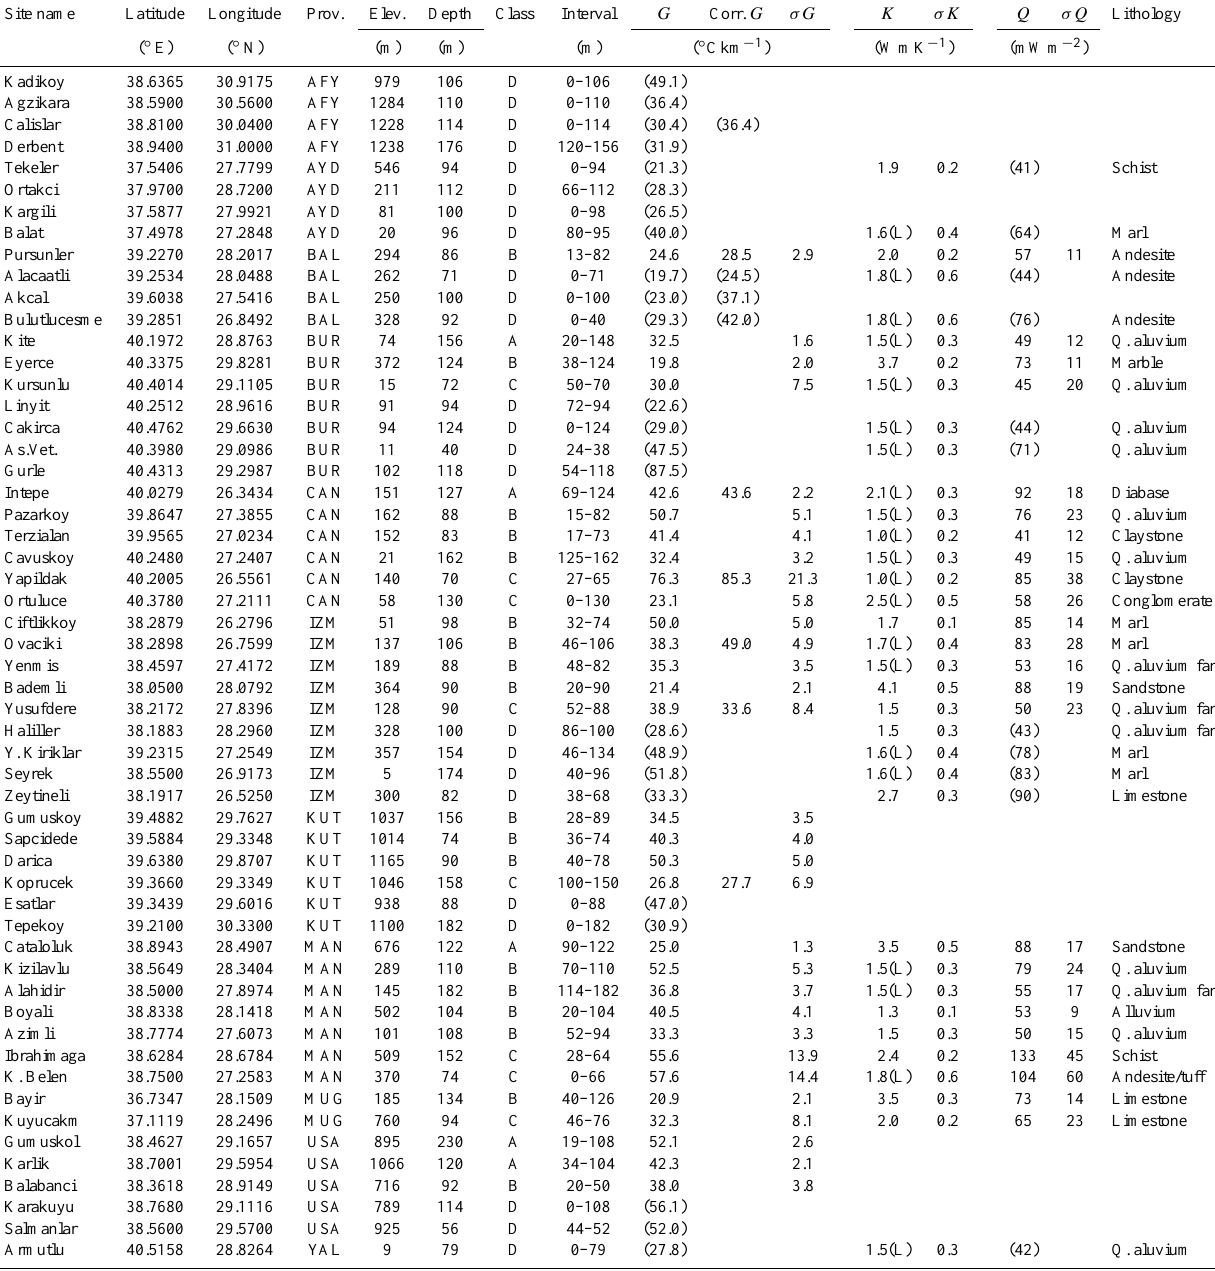
Table 2. Class (A/B/C/D)-type data used in this study, along with gradients, thermal conductivities, heat flow values, and their respective errors. For sites where thermal conductivities cannot be quantified, only gradients are listed. Gradient/heat flow values in parentheses are estimated values without formal error (for class D-type data). Literature thermal conductivities are indicated by (L) next to the value, and are obtained from Balkan et al. (2015), Blackwell and Steele (1989), and Clark (1966). Depth intervals starting with z = 0 indicate that the gradient is calculated based on a hypothetic line using the projected mean annual surface temperature. See the caption of Fig. 1 for administrative province names; G : geothermal gradient; K : thermal conductivity; Q : (corrected) heat